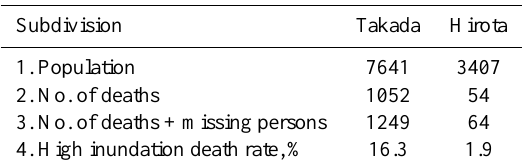
Table 4. Population and fatality information for subdivisions in Rikuzen-Takada